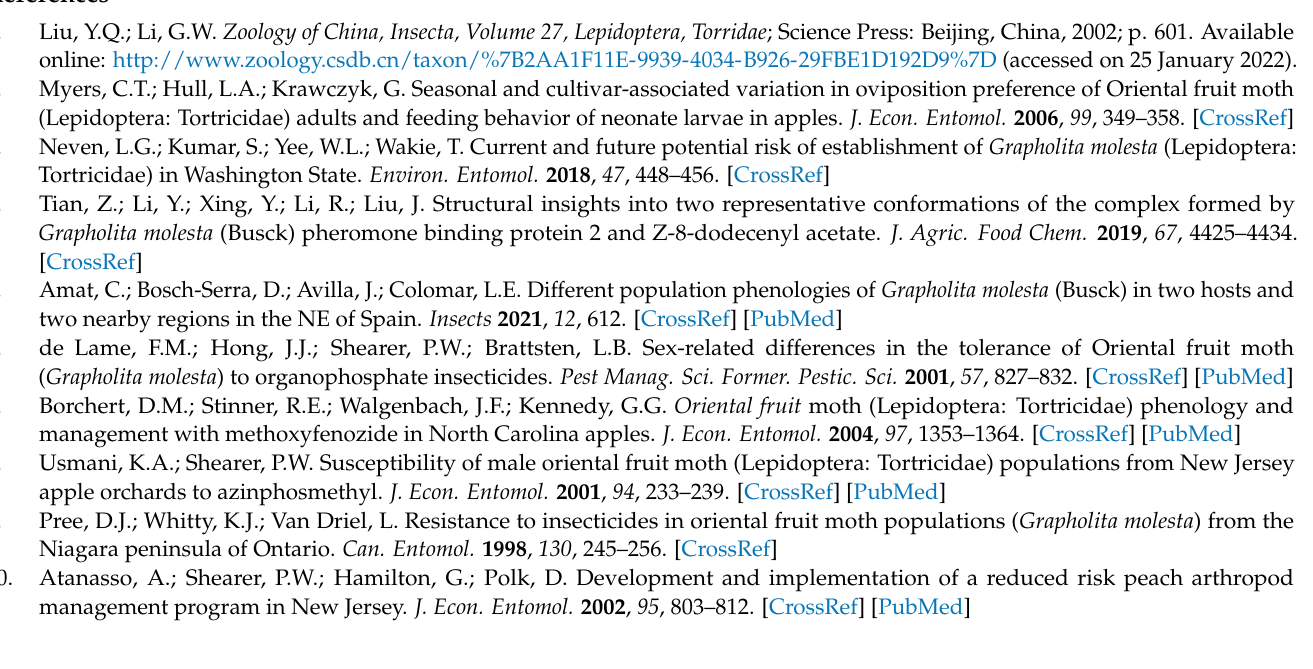
Table S3: Physicochemical properties of G. molesta P450s; Table S4: Signal peptides of G. molesta P450s; File S1: The prediction of these 8 genes by TMHMM and the tertiary structure of 8 P450 genes predicted by